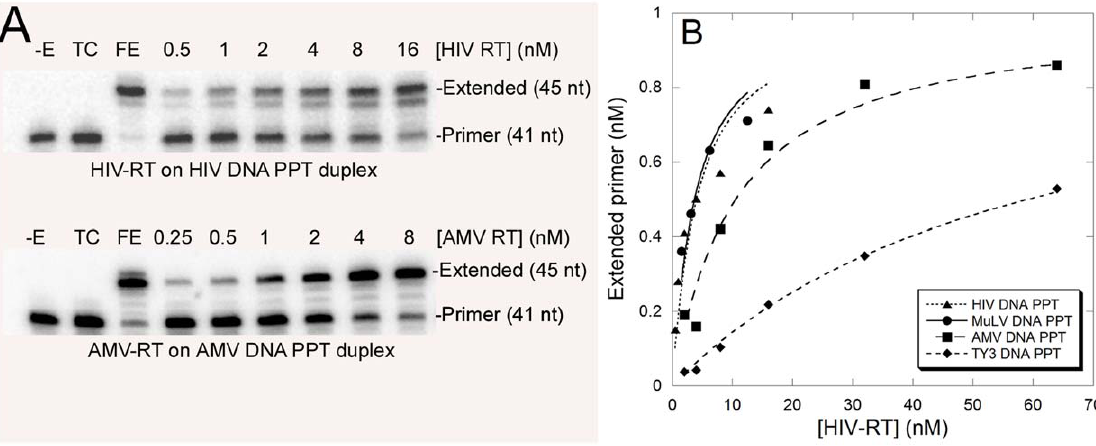
Figure 2. Example of assays and plots used to determine K d values for the duplex shown in Fig. 1. (A) An autoradiogram of an experiment performed with HIV (top panel) or AMV (bottom panel) RT on their cognate designed DNA PPT constructs (HIV DNA PPT, and AMV DNA PPT duplex, respectively) (see Fig. 1). Positions for the unextended and extend primer are indicated as is the amount of enzyme used in each assay. – E, no enzyme control; TC, trap control to test for trap efficiency in which the enzyme and trap were mixed prior to addition to the reactions; FE, full extension control contained the highest amount of enzyme used in the assay incubated with the substrate in the absence of trap for 10 min. Refer to the Methods section for details. (B) A graph of extended primer vs. [HIV RT] for four different designed duplexes (see Fig. 1). The line shown for each duplex was made by fitting the data points to the binding equation described in the Methods section. This line was used to determine the enzyme’s K d for the particular construct. The data shown is from a single experiment with each construct. Experiments were repeated 2–4 times and data presented in Table 1 is an average of those experiments 6 standard deviations.